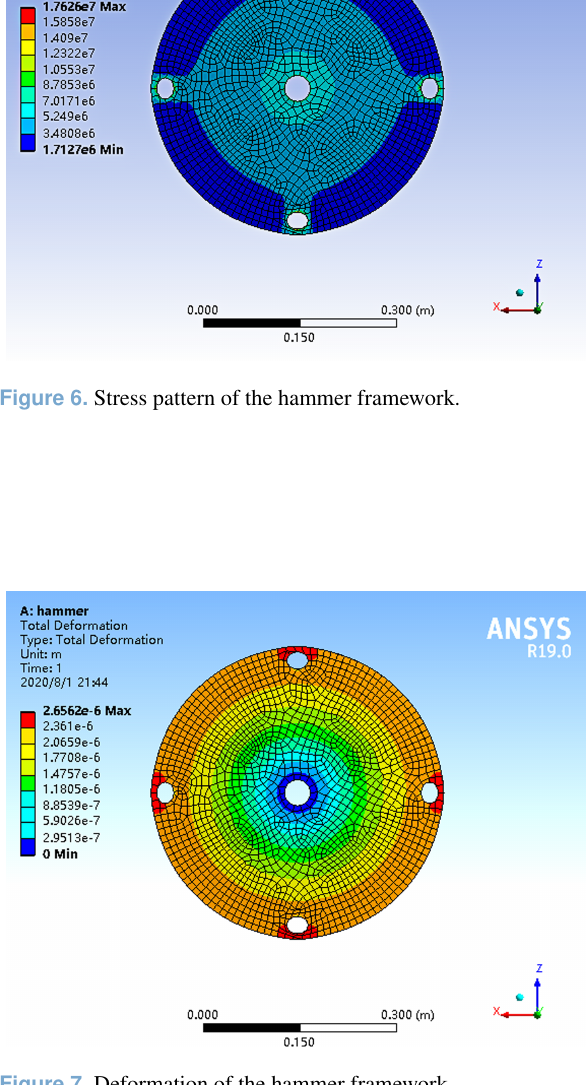
Figure 7. Deformation of the hammer